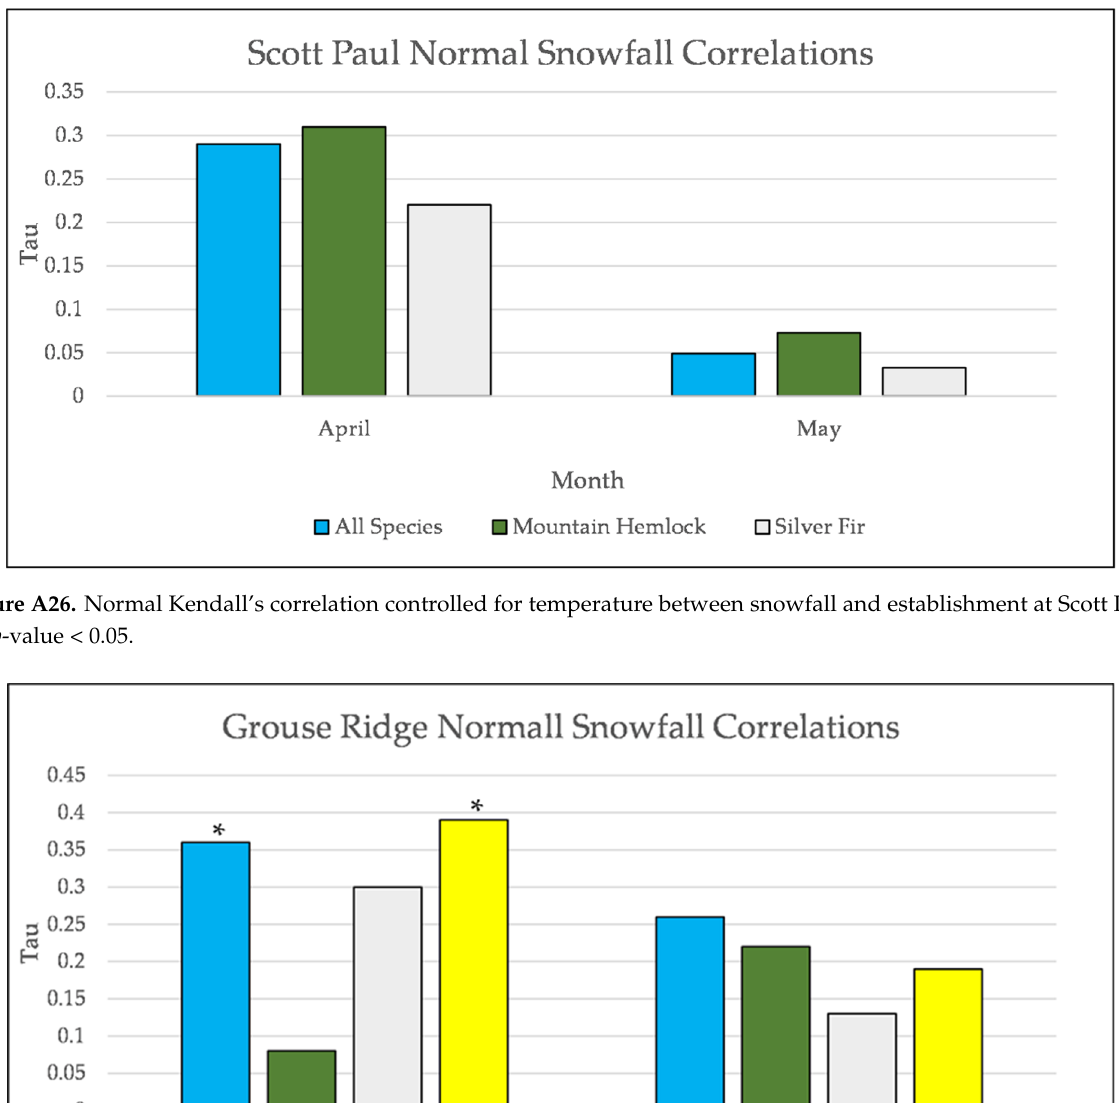
Figure A25. Normal Kendall’s correlation controlled for temperature between snowpack and establishment at Grouse Ridge. * = p -Value < 0.05. July is not included for snowpack at Grouse Ridge because there is rarely any snowpack at Grouse Ridge in July.